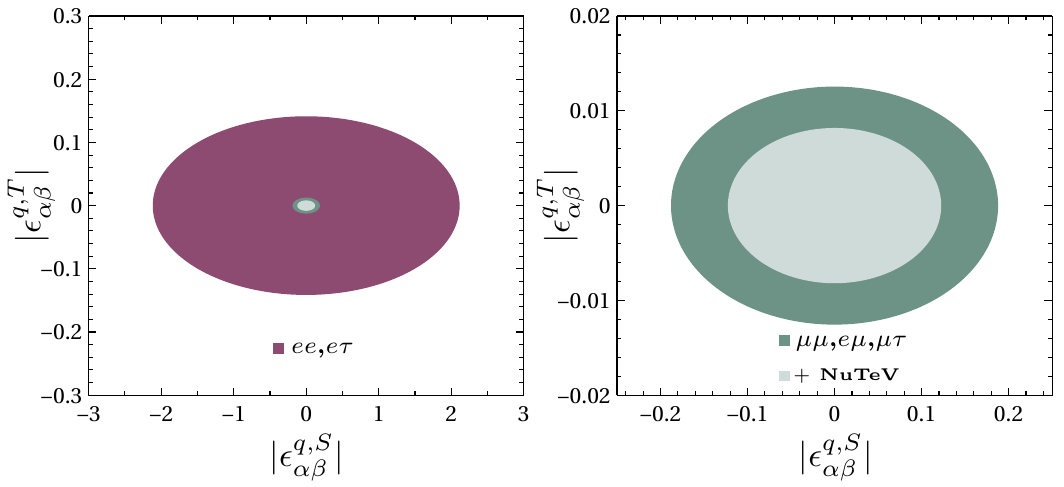
Figure 5 . Global constraints on the scalar and tensor neutrino-quark parameters, at 90% C.L. The same combination of experiments as in table 6 was used. In the left panel we show the less stringent constraints corresponding to the parameters with flavor index ee and eτ . The other constraints, with and without including data from NuTeV, are presented in the right panel. As a reference for the reader, we also include the stronger constraints in the left